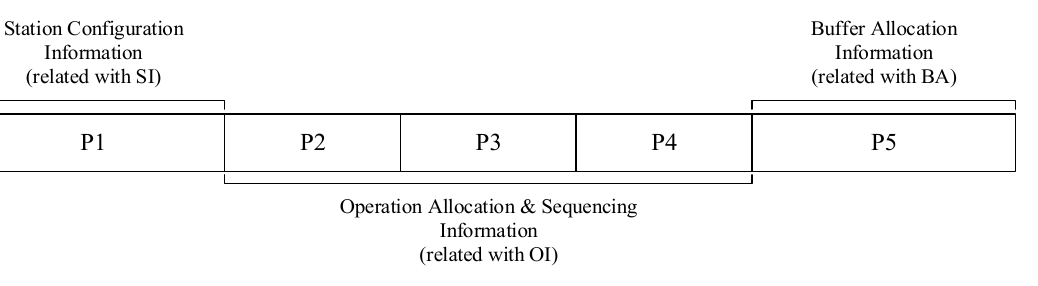
Figure 4. Synthetic representation of code P for each individual.